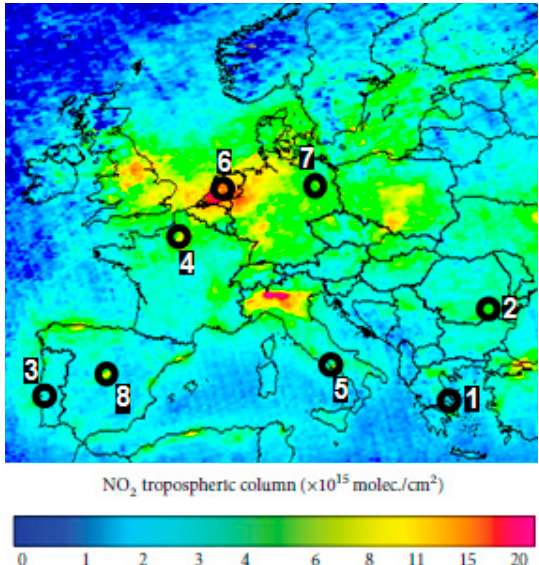
Figure 1. Spatial distribution of the selected cities using the 2014 Europe OMI NO 2 map (Legend: 1—Athens, 2—Bucharest, 3—Lisbon, 4—Paris, 5—Rome, 6—Rotterdam, 7—Berlin, 8—Madrid).